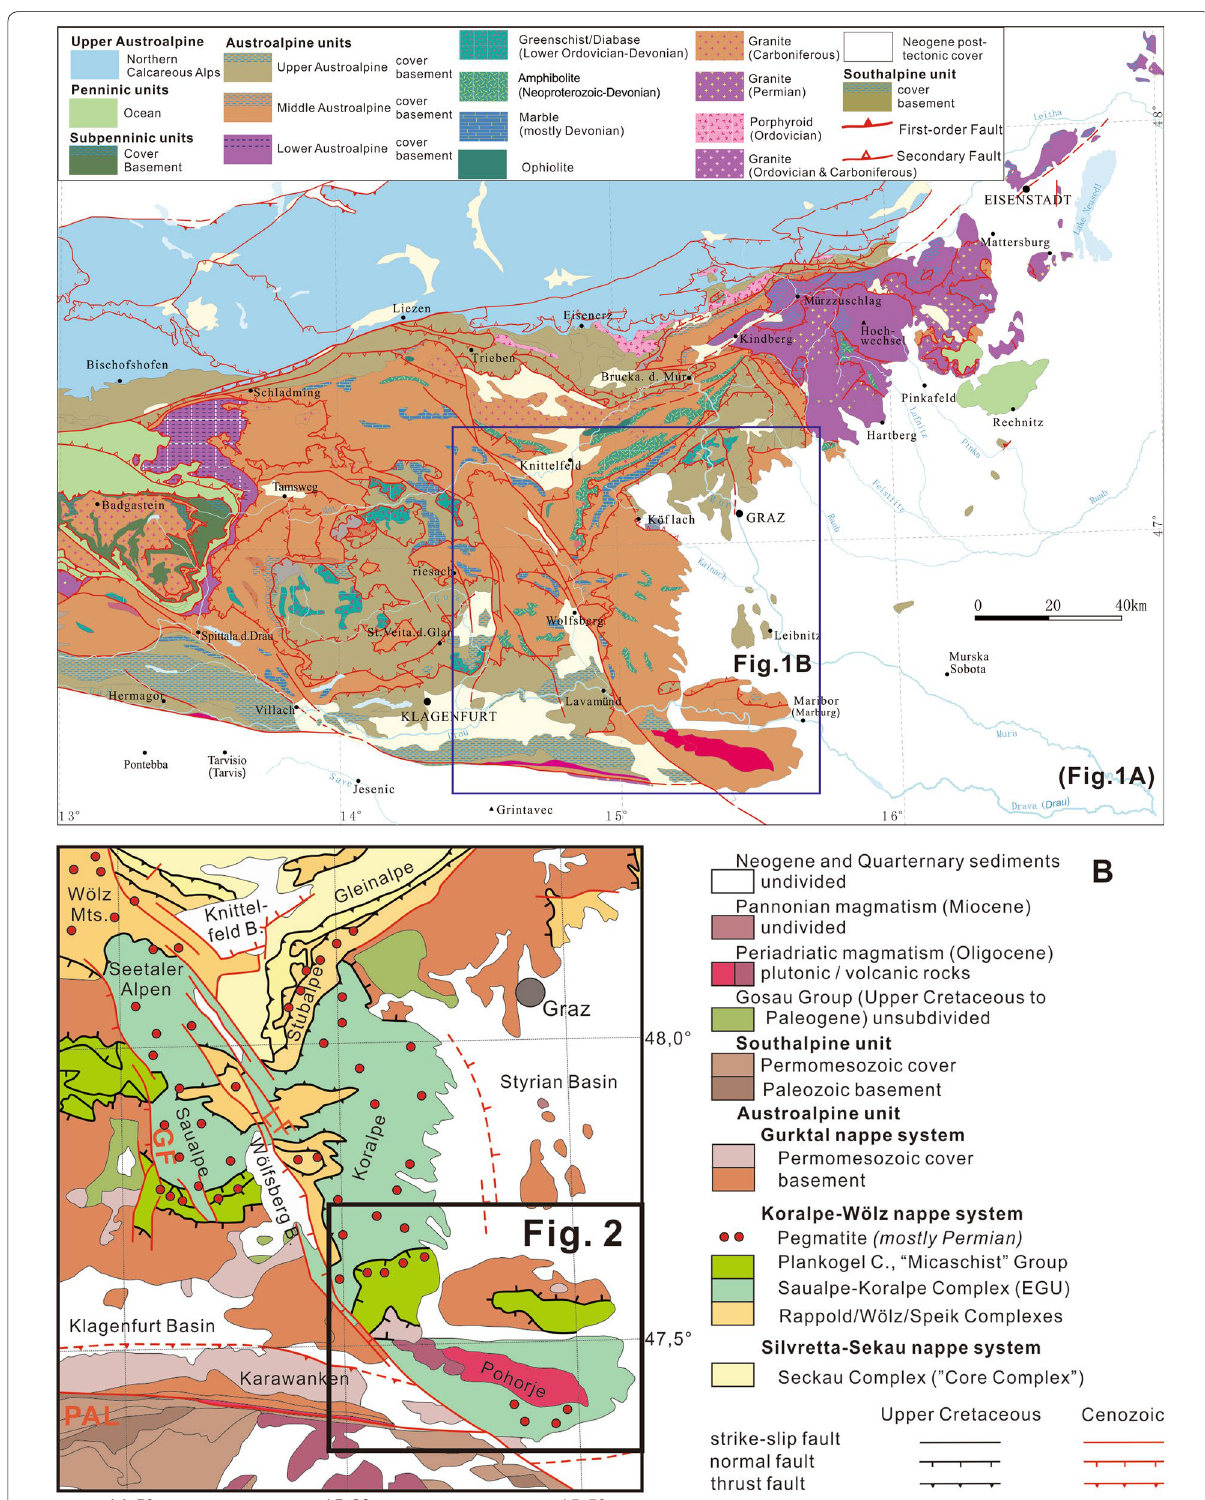
Fig. 1 a Geological map of the eastern part of the Eastern Alps. b Tectonic map of the Saualpe-Koralpe-Pohorje area (modified after Miller et al.